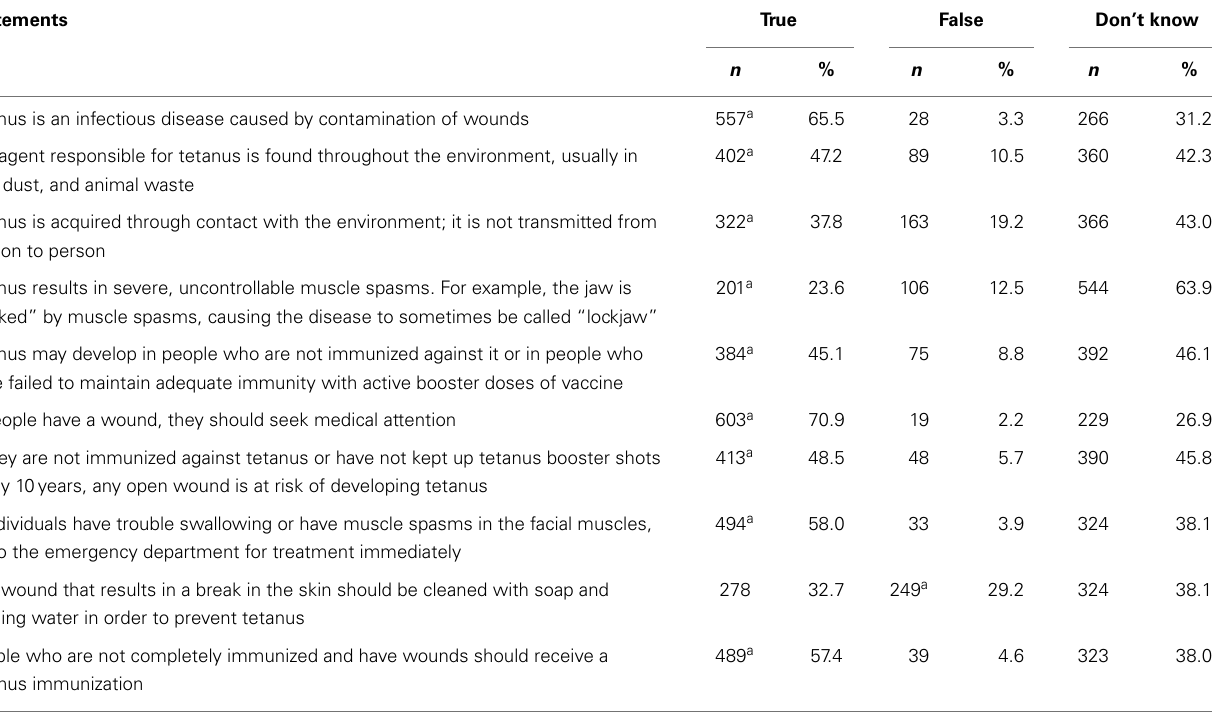
Table 2 | Responses of the high school girls to various statements on tetanus